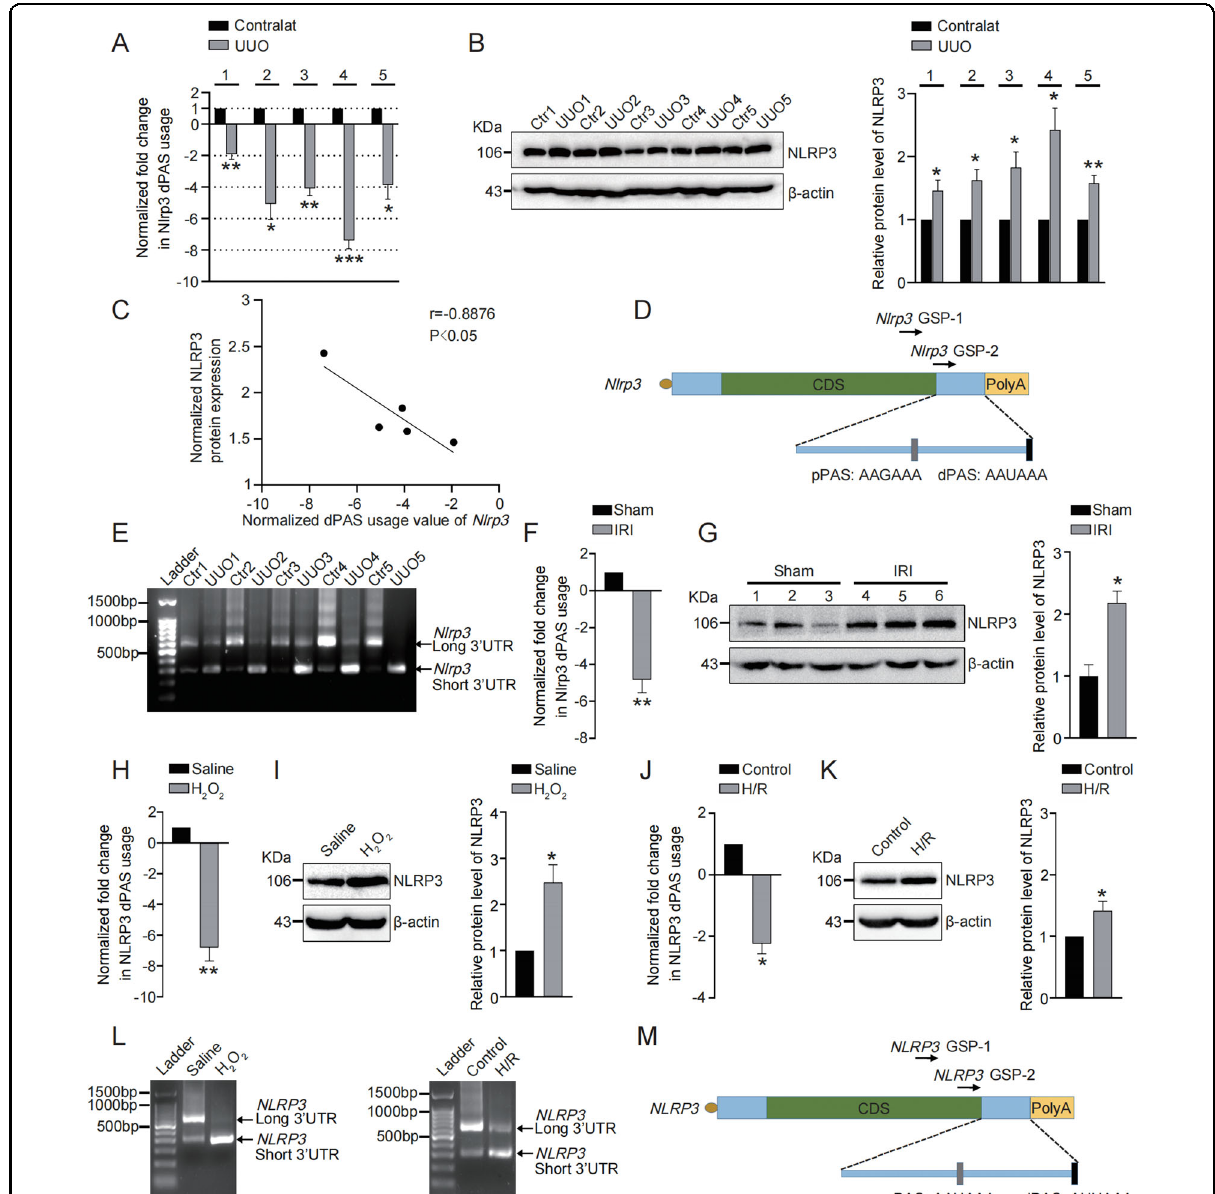
Fig. 1 3 ′ UTR of NLRP3 is shortened in response to kidney injury. A qRT-PCR was performed to determine the normalized fold changes of distal PAS usage of NLRP3 in UUO kidneys ( n = 5) compared to normal kidneys ( n = 5). B Western blot was performed and quantitatively analyzed to determine the protein levels of NLRP3 in UUO kidneys ( n = 5) compared to normal kidneys ( n = 5). C Correlation of normalized dPAS usage value of NLRP3 with normalized protein levels of NLRP3. D The schematic graph indicating the novel pPAS in mice and the primer sequences used in 3 ′ RACE assay. Green box, CDS; blue bar, UTR; gray box, the newly-identi fi ed pPAS; black box, canonical dPAS. E 3 ′ RACE was performed to determine the expression of mRNA isoforms of NLRP3 in UUO kidneys ( n = 5) compared to normal kidneys ( n = 5). F qRT-PCR was performed to determine the normalized fold changes of distal PAS usage of NLRP3 in IRI kidneys ( n = 3) compared to normal kidneys ( n = 3). G Western blot was performed and quantitatively analyzed to determine the protein levels of NLRP3 in IRI kidneys ( n = 3) compared to normal kidneys ( n = 3). H qRT-PCR was performed to determine the normalized fold changes of distal PAS usage of NLRP3 in HK2 cells treated with H 2 O 2 . I Western blot was performed and quantitatively analyzed to determine the protein levels of NLRP3 in HK2 cells treated with H 2 O 2 . J qRT-PCR was performed to determine the normalized fold changes of distal PAS usage of NLRP3 in HK2 cells treated with H/R. K Western blot was performed and quantitatively analyzed to determine the protein levels of NLRP3 in HK2 cells treated with H/R. L 3 ′ RACE was performed to determine the expression of mRNA isoforms of NLRP3 in HK2 cells treated with H 2 O 2 or H/R. M The schematic graph indicating the novel pPAS in human and the primer sequences used in 3 ′ RACE assay. Green box, CDS; blue bar, UTR; gray box, the newly-identi fi ed pPAS; black box, canonical dPAS. * P < 0.05; ** P < 0.01; *** P < 0.001; All data represent the mean ± SEM obtained from three independent experiments. Student ’ s t test.